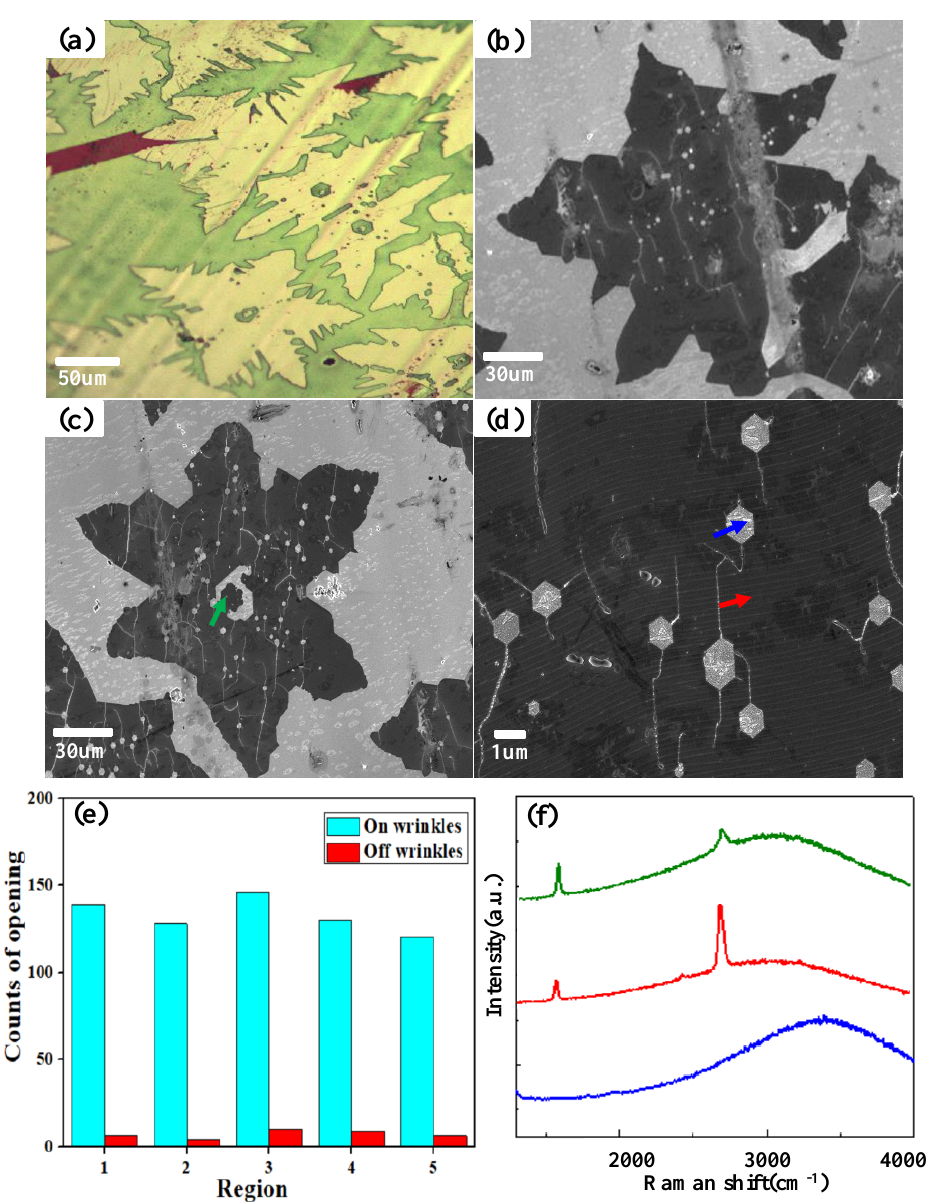
Figure 3. ( a ) Optical microscope image of H 2 -induced etching of wrinkled graphene domains. ( b ) SEM image of the etched monolayer wrinkled graphene domain. ( c ) SEM image of the etched multilayer wrinkled graphene domain. ( d ) Magnified SEM image of etching features of wrinkled graphene. ( e ) Percentage of etched openings on and off wrinkles. Five regions were randomly picked for the calculation of etched openings; each region is 100 μm × 120 μm. ( f ) Raman spectra of the intact monolayer graphene (pointed by red arrow), etched region (pointed by blue arrow), and multilayer graphene (pointed by green arrow) on Cu foil.